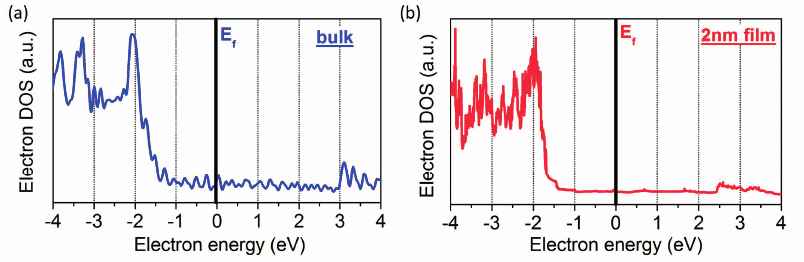
Figure 10. The electron density of states for ( a ) bulk gold and ( b ) a 2 nm-thick film of